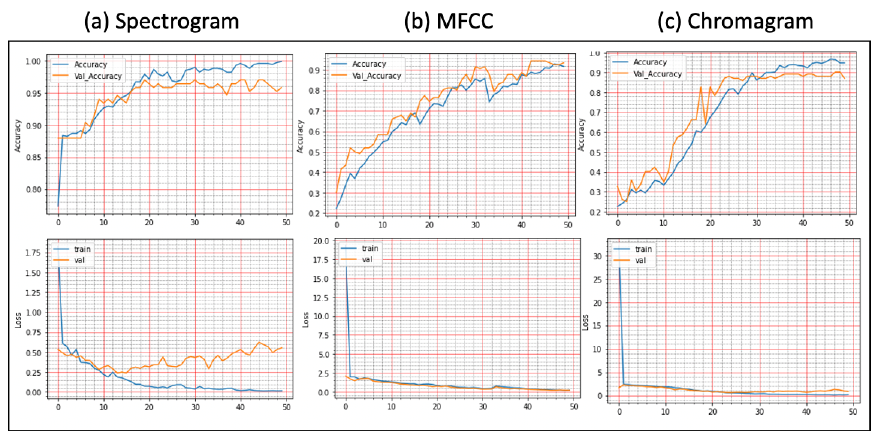
Figure 7. Accuracy for Lung/Heart Condition Detection (Augmented Dataset).